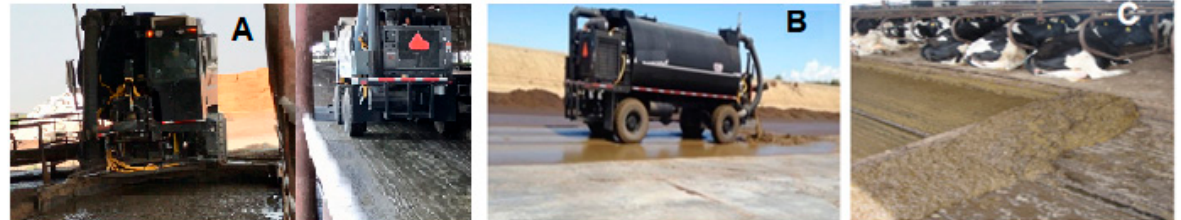
Figure 1. Manure vacuuming and scraping: ( A ) Front and back of a vacuum truck collecting manure from a barn; ( B ) collected manure sprayed on a concrete slab for sun drying; and ( C ) scraper blades pulled with chain.